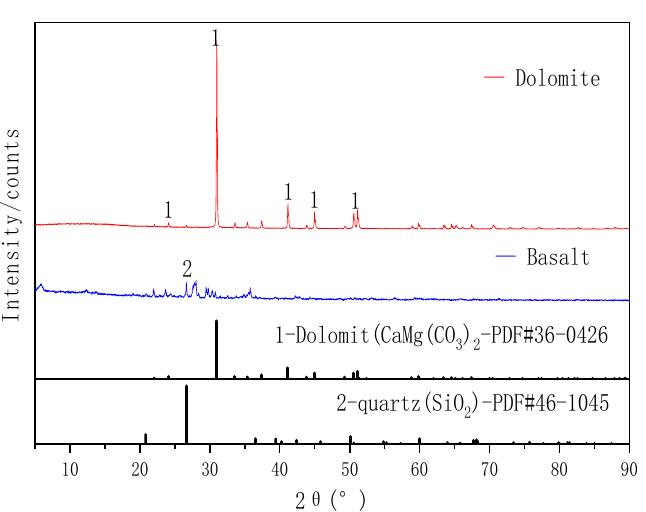
Figure 3. XRD patterns of the aggregates (1: dolomite (CaMg(CO 3 ) 2 ), 2: quartz (SiO 2 )).